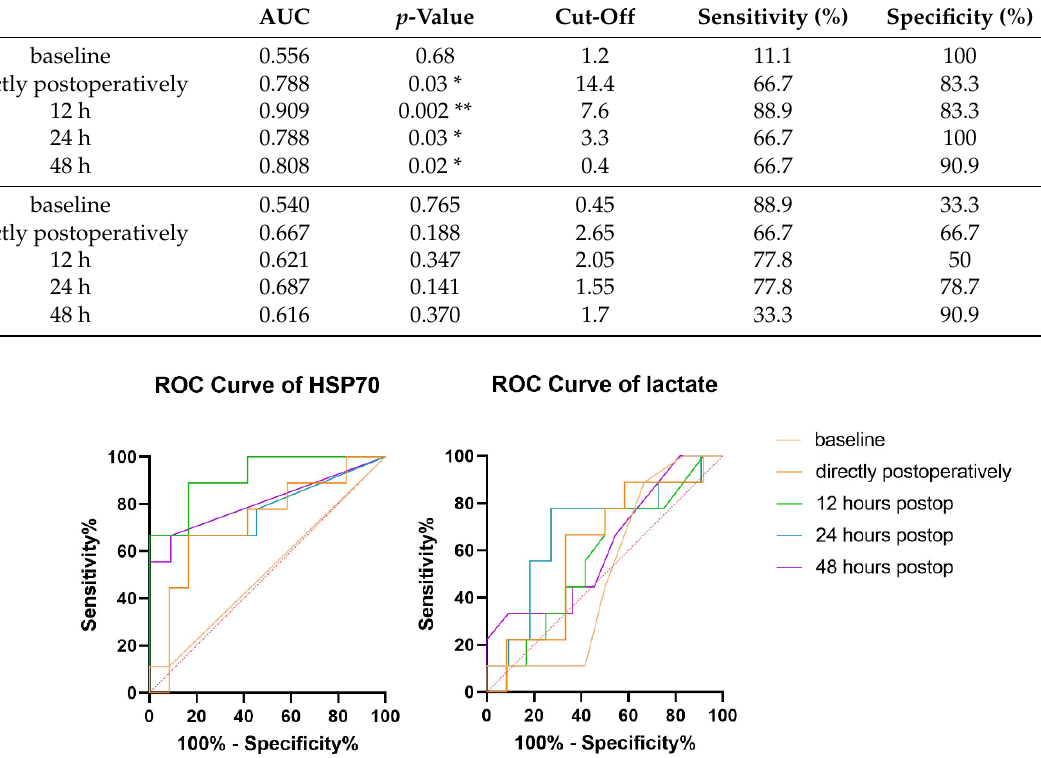
Table 5. ROC analysis for heat-shock protein 70 (HSP70) and lactate serum levels at different postoperative time points for patients with abdominal complications ( n = 9). Cut-off was calculated with the Kolmogorov–Smirnov test. Significance marked with (*) for p < 0.05 and (**) for p < 0.01.